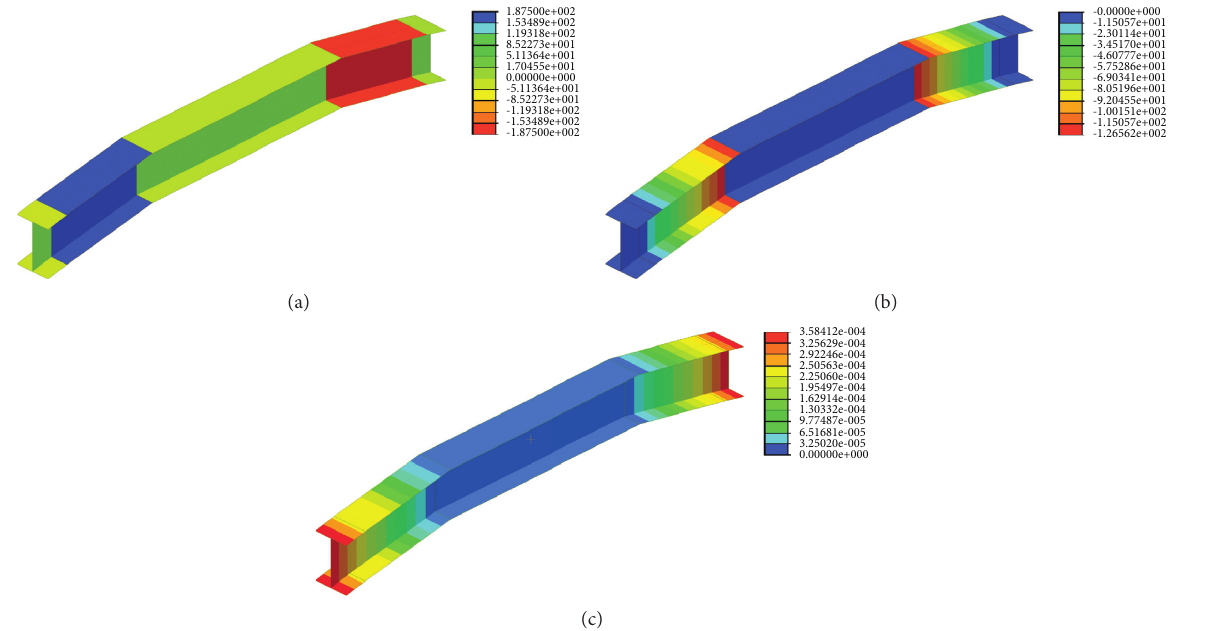
Figure 9: State of the upper reaction beam: (a) bending moment diagram of the lower reaction beam; (b) shear diagram of the lower reaction beam; (c) displacement diagram of the lower reaction beam.